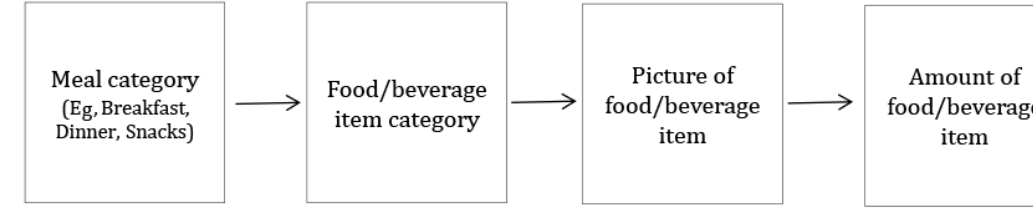
Figure 2. Flowchart on the dietary recording function in module